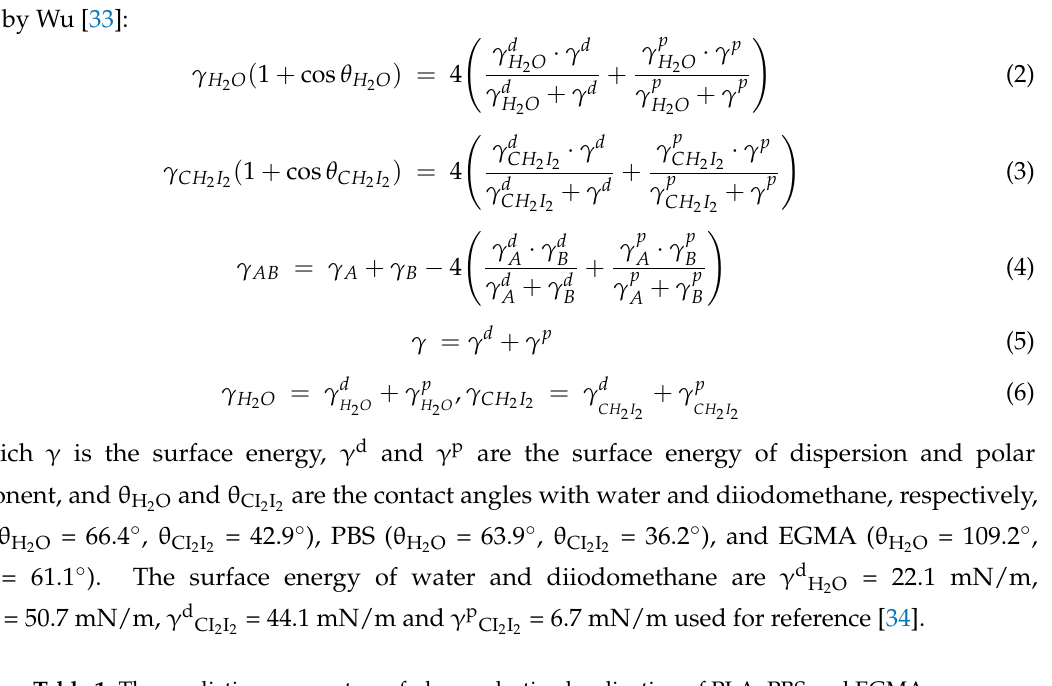
Table 1. The prediction parameters of phase selective localization of PLA, PBS and EGMA. Surface Tension (mN/m) Sample